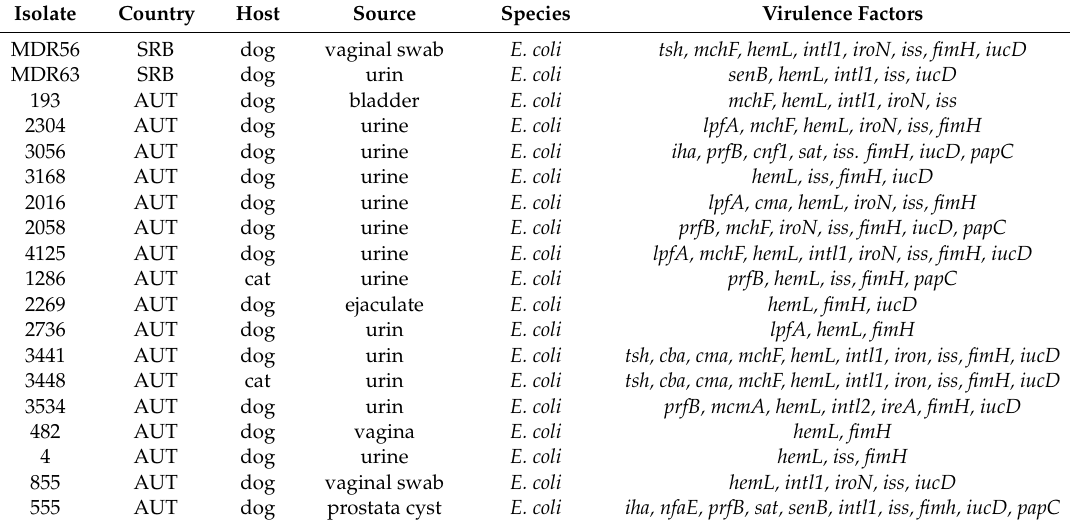
Table 3. Virulence factors detected in E. coli isolates obtained from dogs and cats with urogenital infections and originating from Austria (AUT) and Serbia (SRB).